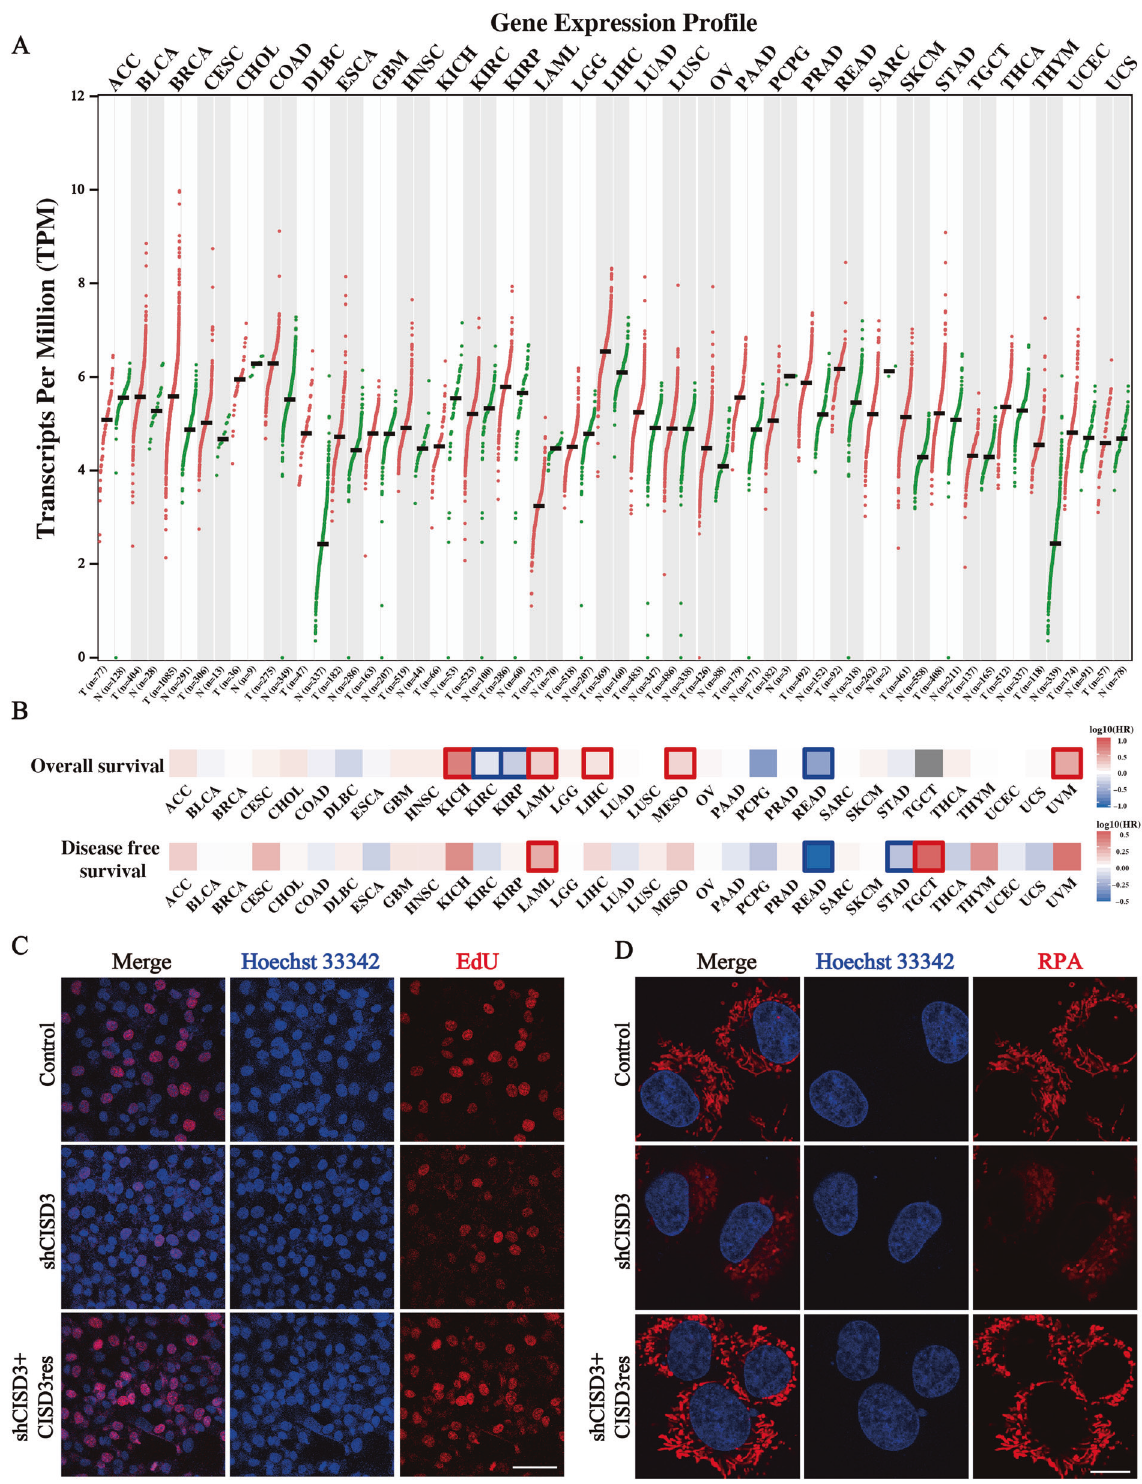
Fig. 1 Association of CISD3 expression with cancer progression and iron metabolism. A Gene expression pro fi le of CISD3 in various kinds of TCGA cancers and its homologous normal samples, which is obtained from the GEPIA website (http://gepia.cancer-pku.cn/index.html). B CISD3 expression was classi fi ed into two subgroups (high or low group) using the median level of CISD3 expression as the cut-off value. Survival map of Hazards Ratio (HR) for overall survival (OS) and disease-free survival (DFS) according to the low and high expression levels of CISD3 mRNA. C The proliferation of HT-1080 cells with different CISD3 expressions was detected by the EdU incorporation assay. Nuclei were visualized with Hoechst 33342. Scale bar: 50 μ m. D Mitochondrial iron levels measured by RPA staining in control, shCISD3, and CISD3res HT- 1080 cells and images were captured by confocal microscopy. Scale bar: 5 μ